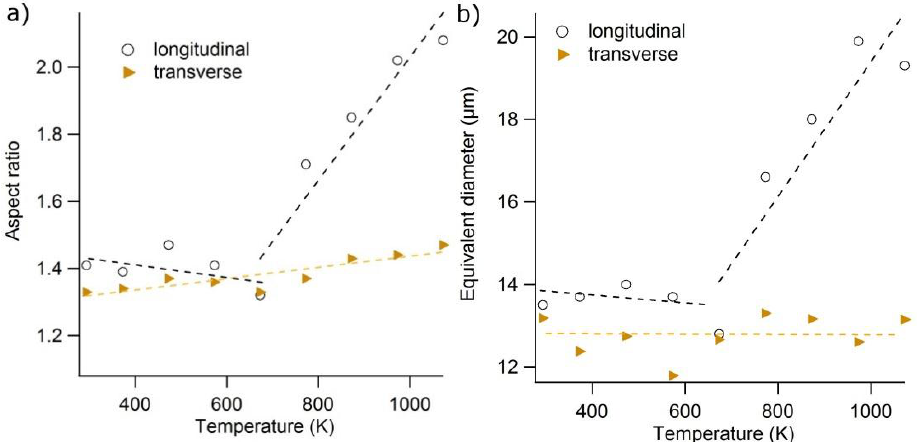
Figure 5. Variation of ( a ) the aspect ratio and ( b ) the equivalent diameter of voids around graphite nodules with the temperature in the transverse and longitudinal planes, close to the fracture zone after tensile